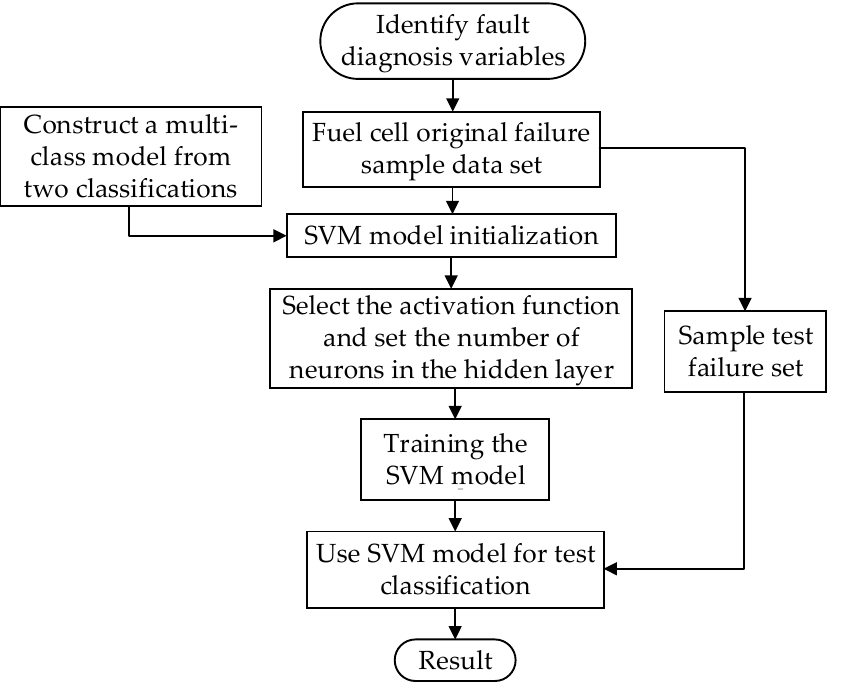
Figure 6. Flow diagram of the SVM diagnosis